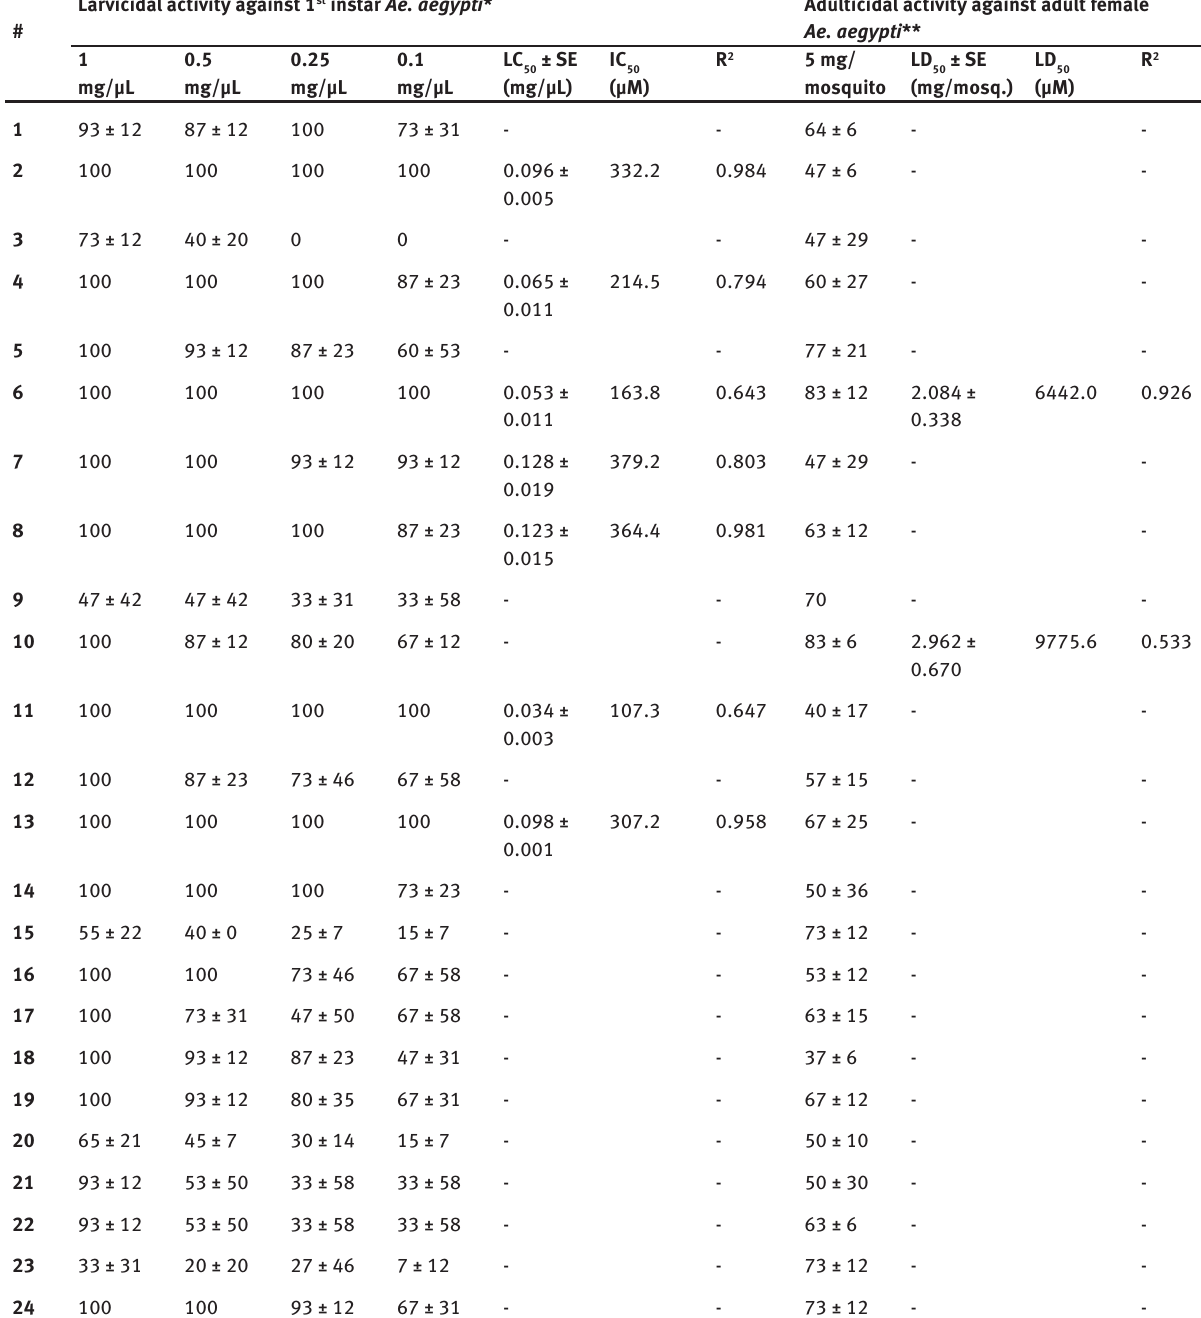
Table 2: Twenty-four hour larval and adult topical mortality of compounds 1 - 24 against the susceptible Orlando (ORL1952) strain of Ae. aegypti. Larvicidal activity against 1 st instar Ae. aegypti